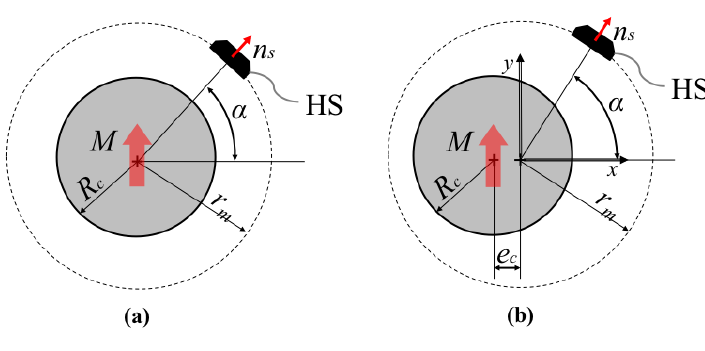
Figure 2. Layout of the sensing principle ( a ) traditional sensing with sinusoidal-like output ( b ) modified layout with eccentricity.